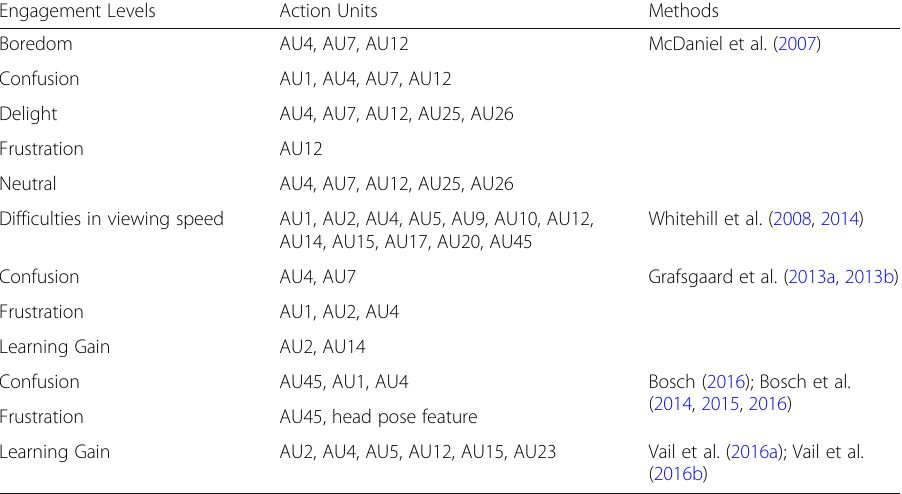
Table 1 List of AUs involved in engagement detection using facial expressions in online learning Engagement